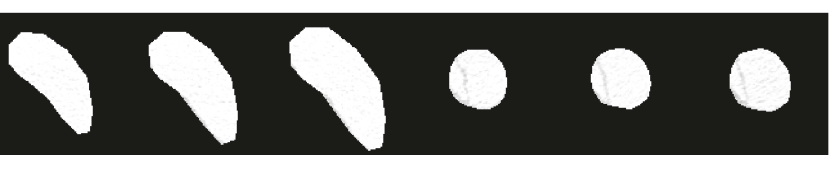
Figure 10: Aortic arch and descending aorta segmentation results by three methods.